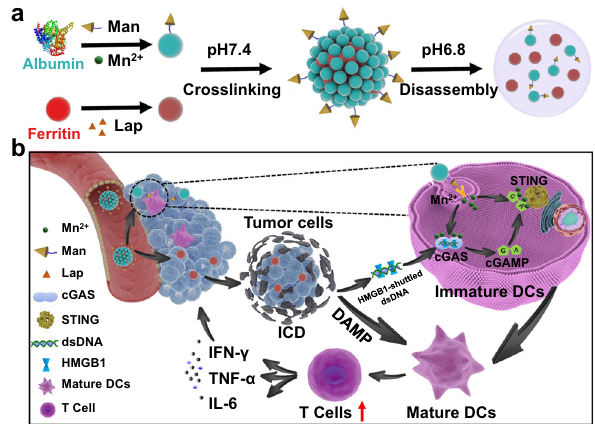
Fig. 1 | On-demand activation of the protein-based nanoassembly in TME enhances the immune response of poorly immunogenic solid tumors. a Preparation procedure of the protein nanoassembly and its activation in TME. b Schematic illustration of nanoassembly-mediated enhanced immunotherapy in poorlyimmunogenicsolidtumors.ThesystemicallyadministeredBSA-Man@Mn 2+ - Ft@Lap nanoassembly rapidly disintegrated in the perivascular region of solid tumors into highly diffusive BSA-Man@Mn 2+ and Ft@Lap components, thus enabling enhanced penetration into the tumor interior. Ft@Lap molecules would bind to the transferrin receptors on tumor cells for targeted Lap delivery to elicit ef fi cient immunogenic apoptosis, leading to the release of abundant DAMPs including HMGB1 and dsDNA. Meanwhile, BSA-Man@Mn 2+ molecules were selec- tivelyinternalized by immatureDCsto enhancethe dsDNA sensitivity of the cGAS- STING axis. These activities would act in a cooperative manner to promote DC maturation and cross-priming, eventually enhancing the in fi ltration and effector function of tumor-speci fi c T cells for ef fi cient